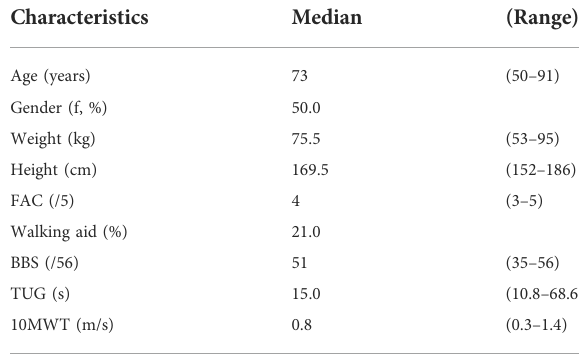
TABLE 1 Cross-validated grid search hyperparameter combinations. TABLE 2 Participants ’ demographic data ( N = 14).